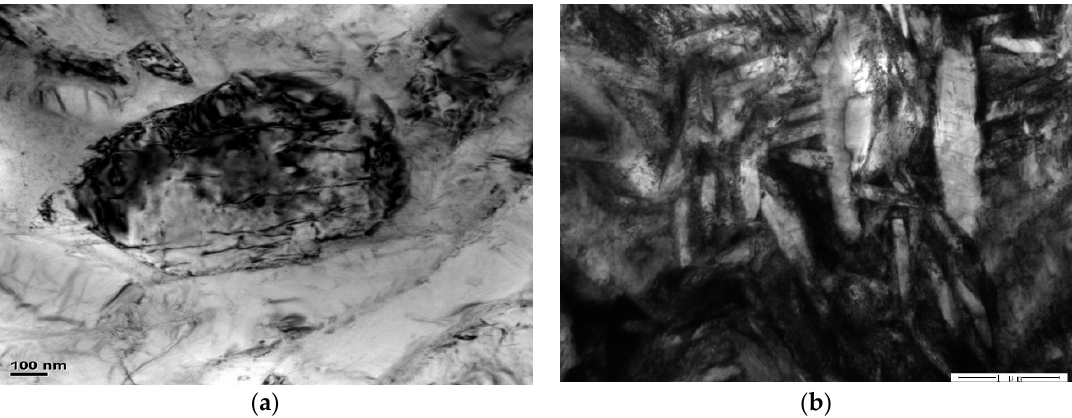
Figure 11. TEM images of creep sample HT-840 at 650°C/150MPa, ( a ) α 2 particles, ( b ) lamellar O phase.